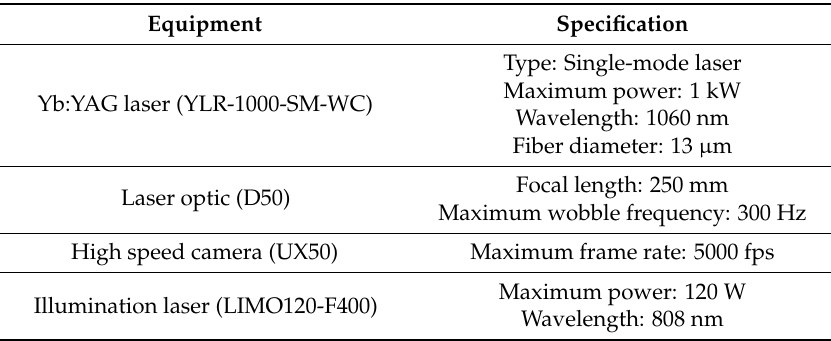
Table 3. Equipment and its specification applied in